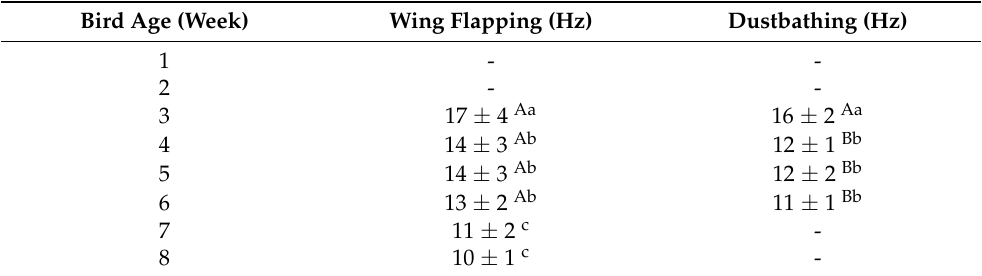
Table 5. Behavioral frequency of wing flapping and dustbathing at different bird ages (mean ± SD). Bird Age